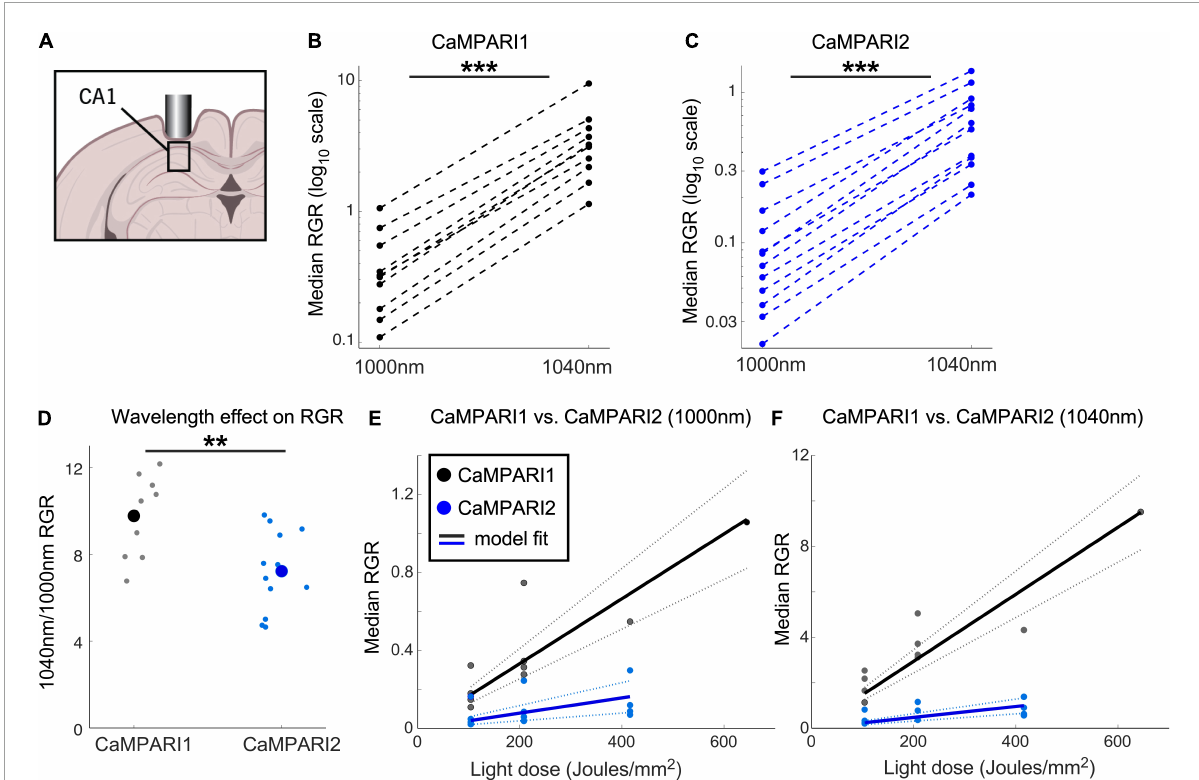
FIGURE3 Comparing the PC performance of CaMPARI1 and CaMPARI2 in the mouse hippocampus. (A) Schematic illustration of hippocampal recording of CA1 neurons. (B,C) Comparing the median RGR for CaMPARI1 (B) and CaMPARI2 (C) shows similar increases in RGR with longer wavelength excitation to cortical recordings (Figure 2) . RGR was recorded from all identified cells in CA1 for all recording experiments and median values are shown (4 mice for CaMPARI1 with 370, 320, 461, and 258 cells/mouse; 3 mice for CaMPARI2, one mouse was recorded twice with 205 and 448 cells/recording and the other mice with 228, and 174 cells/mouse). The RGR readout was performed sequentially using 1,000 nm and then 1,040 nm excitation wavelengths. Lines connect data points acquired from the same mouse during the same session. Note the logarithmic scale of the y-axis. (D) The ratios of median RGR values acquired from the same mice at 1,000 and 1,040 nm excitation wavelengths were significantly higher for CaMPARI1 than CAMPARI2 mice [9.77 ± 1.82 vs. 7.22 ± 1.85, respectively, mean ± std.; p = 0.0062, Wilcoxon Ranksum Test; data from the same mice as in (B,C) ]. Small circles show the ratio for the medians of individual recordings and the large circles are the means across all data points. (E) The median RGR across all recorded CA1 neurons showed linear increases with the light dose used for PC, with substantially higher PC rate for CaMPARI1 than CaMPARI2. The individual data points (gray and blue circles for CaMPARI1 and CaMPARI2, respectively) show the median RGR across all cells within a single mouse in a single light dose recording. Same mice as in (B,C) , each mouse was recorded 1–3 times with different light doses. Data were fit with a linear model with zero intercept [black and blue solid lines for CaMPARI1 and CaMPARI2; slopes of 1.7 × 10 − 3 and 3.9 × 10 − 4 (RGR/light dose) for CaMPARI1 and CaMPARI2, and p = 5 × 10 − 6 and p = 0.0011 for the model fit vs. null hypothesis for CaMPARI1 and CaMPARI2, respectively; two-tailed t -tests; same mice as in (B)] . Dashed lines show 95% confidence intervals. (F) Same representation as in (E) for excitation with 1,040 nm [slopes of 1.5 × 10 − 2 and 2.4 × 10 − 3 (RGR/light dose) for CaMPARI1 and CaMPARI2, and p = 4 × 10 − 7 and p = 4.5 × 10 − 5 for the model fit vs. null hypothesis for CaMPARI1 and CaMPARI2, respectively; two-tailed t -tests; same mice as in (C,E)] . ** p < 0.01, *** p <